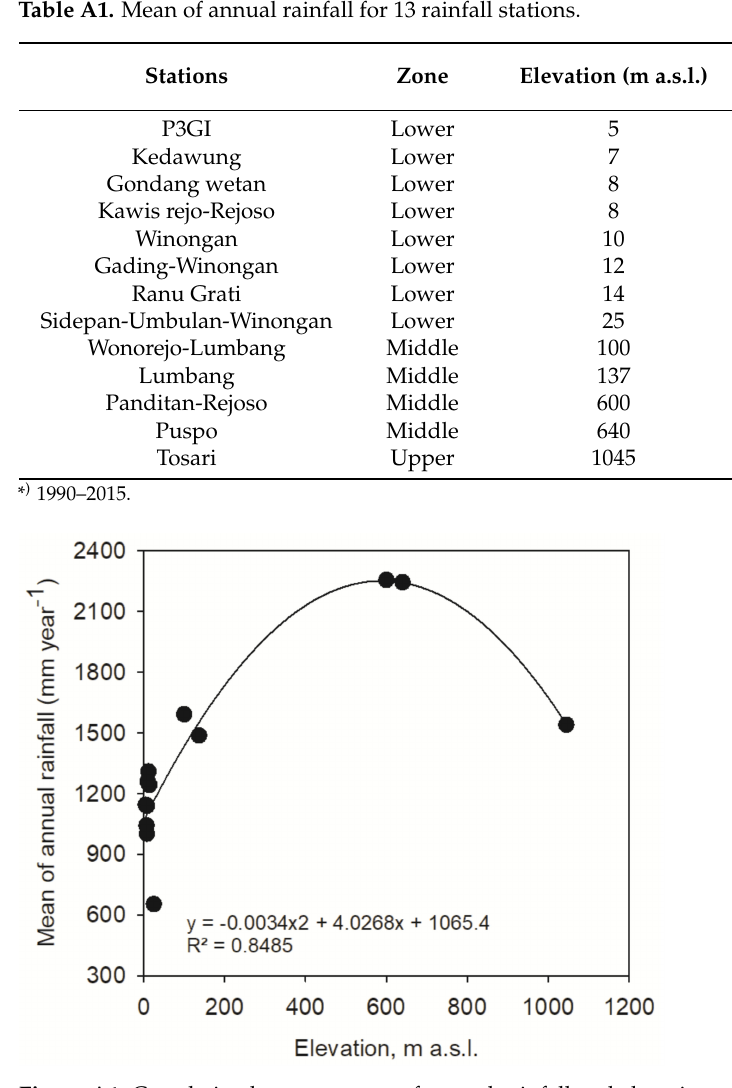
Figure A1. Correlation between mean of annual rainfall and elevation of 13 rainfall stations. Table A2. Potential evapotranspiration of three zones.